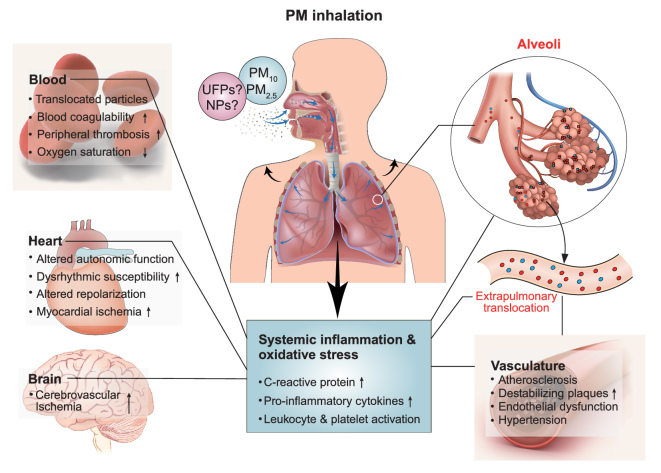
General toxicological pathways linking PM lung exposure to cardiovascular and cerebrovascular diseases that cause morbidity and mortality. The first line of defense against PM is the lung, where PM can induce or exacerbate lung diseases including COPD, asthma, lung infection disease and lung cancer. Furthermore, UFPs could translocate out of the lung into the blood stream and can cause systemic inflammation and oxidative stress that negatively impact blood and blood vessel, heart function and brain.